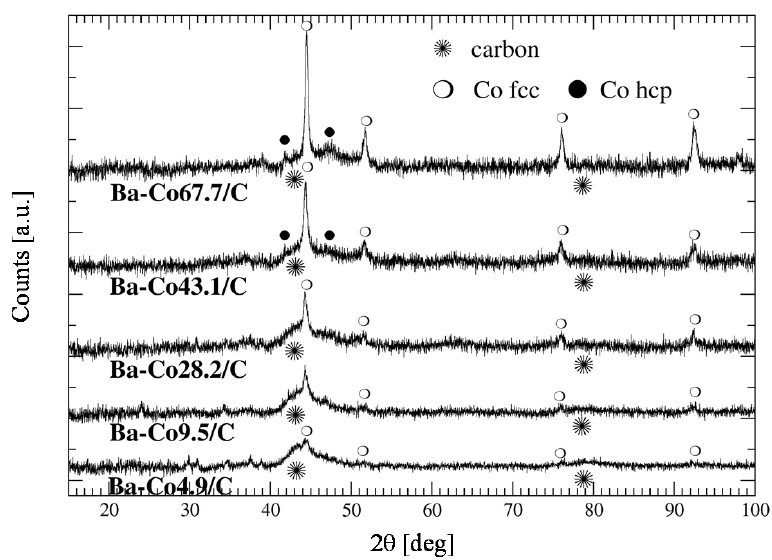
Figure 1. The structure of the carbon support: ( a ) XRPD pattern, ( b ) HRTEM image, ( c ) SAED pat- tern.